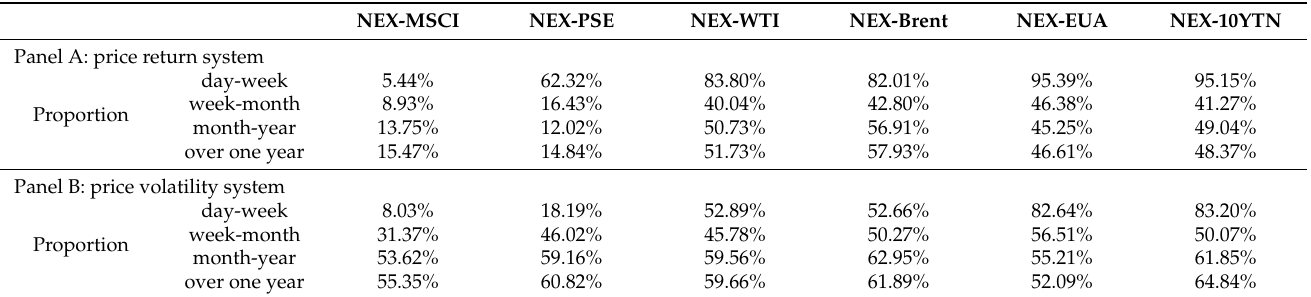
Table 5. Summary statistics on the pairwise connectedness of renewable energy stocks with other variables at different frequency bands.